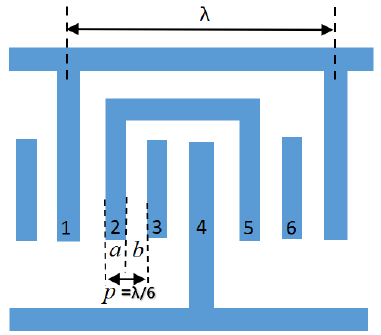
Figure 1. Schematic diagram of FEUDT